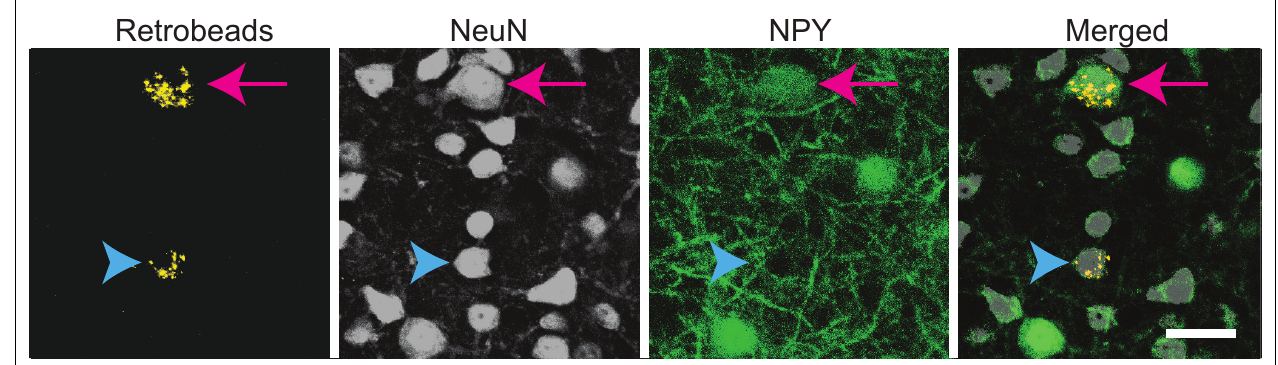
FIGURE 2 | Both NPY+ and non-NPY neurons were labeled by RB after tracer deposits restricted to a single IC subdivision. High magnification images from the left ICc following a 10 nl injection of RB into the right ICc of an NPY-hrGFP mouse. An NPY+ neuron (arrow) and a non-NPY neuron (arrowhead) co-labeled with RB, indicating that they projected to the contralateral ICc. Scale bar = 25 µ